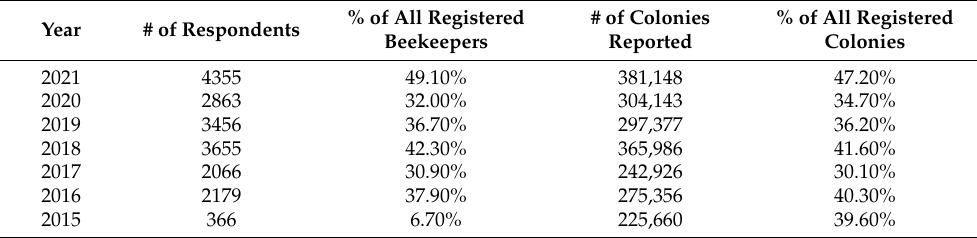
Table 1. New Zealand Colony Loss Survey Response Rates, between the Years